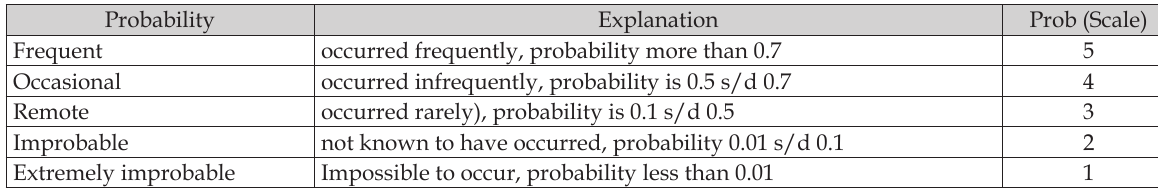
Table 2. Probability of occurrence (State-Argentina